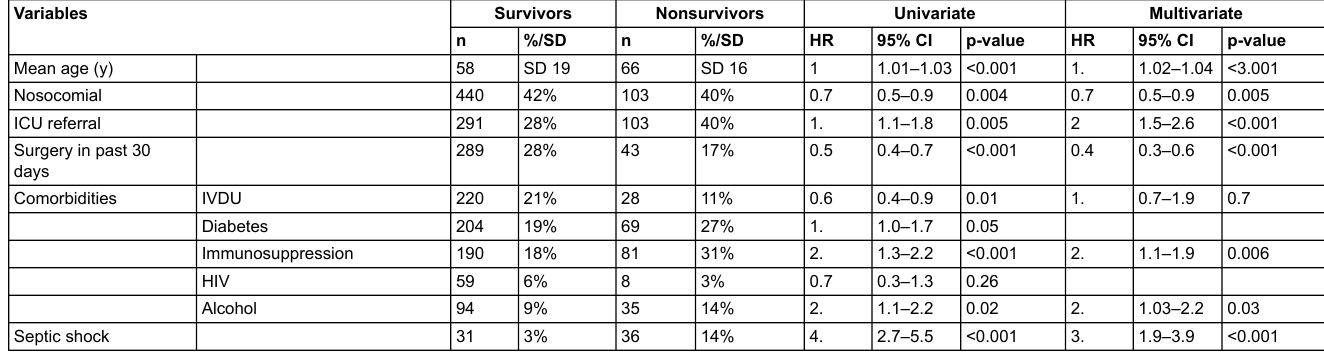
Table 2: a: Uni- and multivariate analysis of demographic factors for mortality.